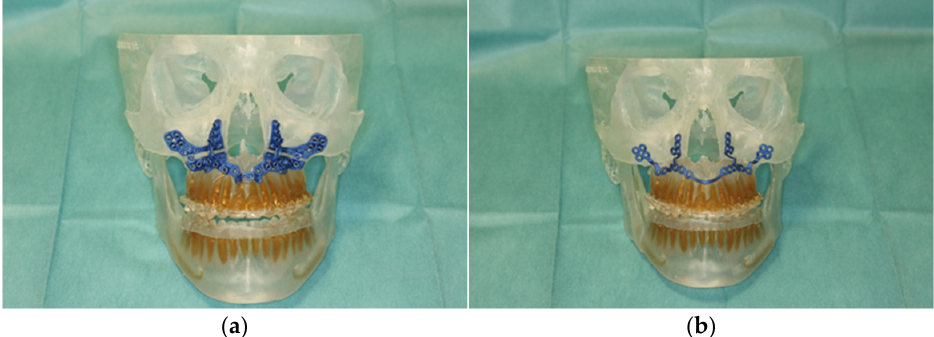
Figure 3. Illustration of patient-specific cutting guide ( a ) and the patient-specific implant (PSI) ( b ) on the 3D-manufactured patient skull.